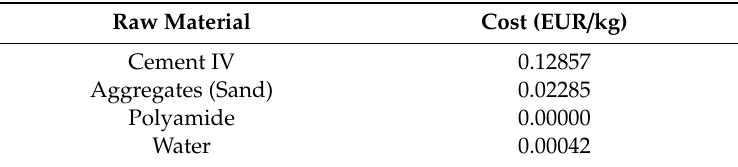
Table 12. Cost of the raw materials.